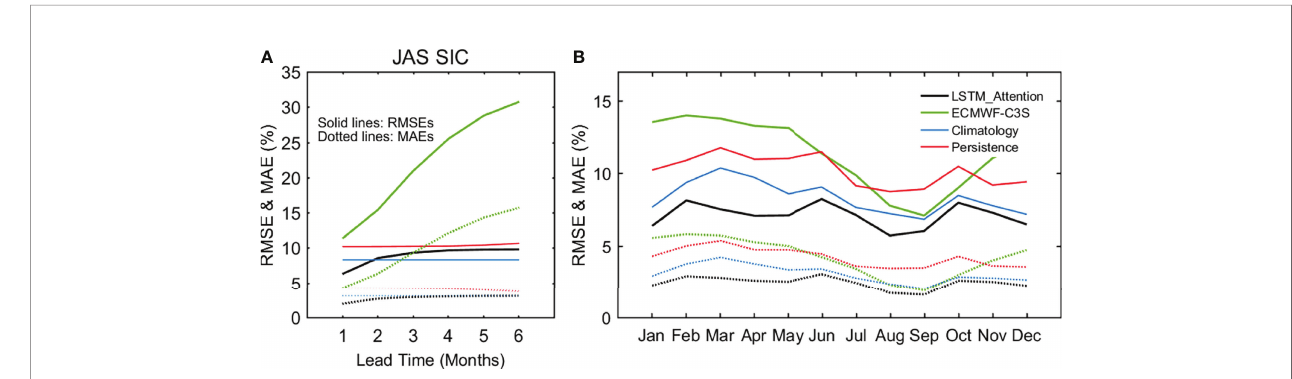
FIGURE 10 | Averaged RMSEs (solid lines) and MAEs (dotted lines) in 2015 – 2020 of the July – August – September (JAS) SIC forecasts at lead times of 1 month to 6 months (A) and averaged RMSEs and MAEs in 2015 – 2020 of monthly SIC forecasts at 1-month lead time (B) using LSTM_Attention, ECMWF-C3S, climatology, and